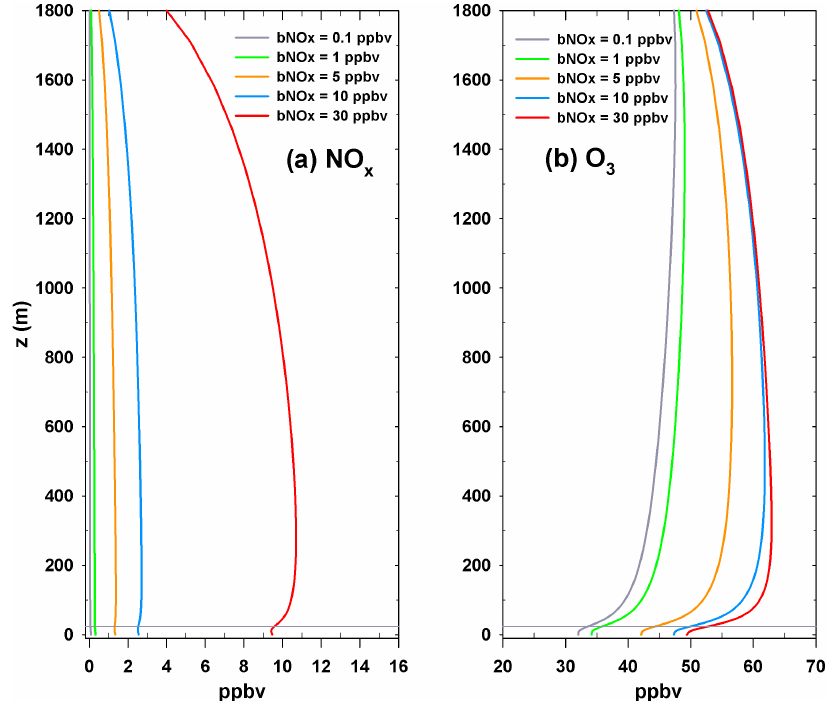
Fig. 6. Steady-state vertical profiles of (a) NO x and (b) O 3 for each background NO x value (horizontal gray line is canopy top height).